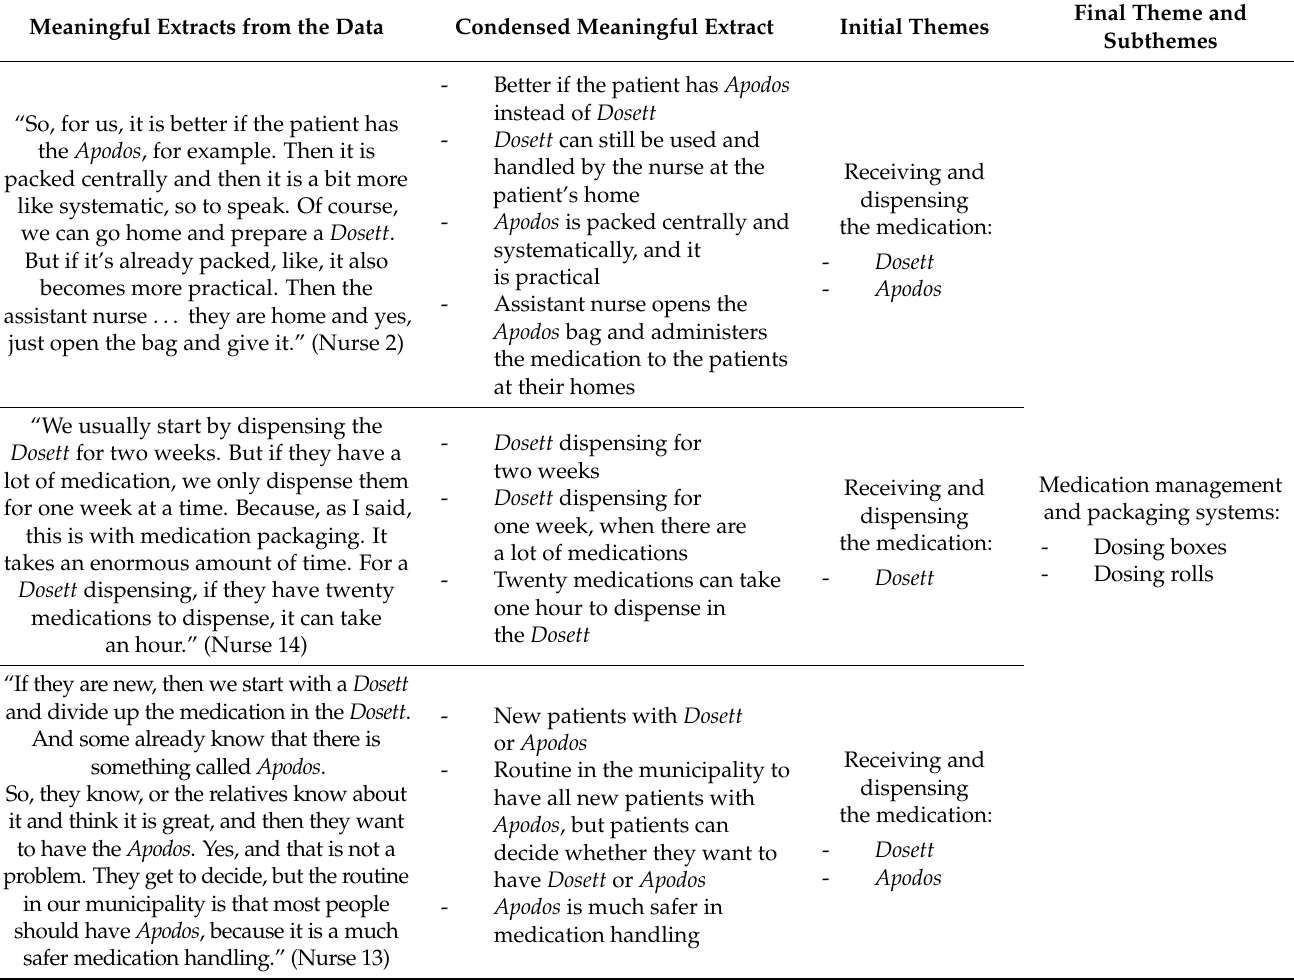
Table 2. Examples illustrating the inductive thematic